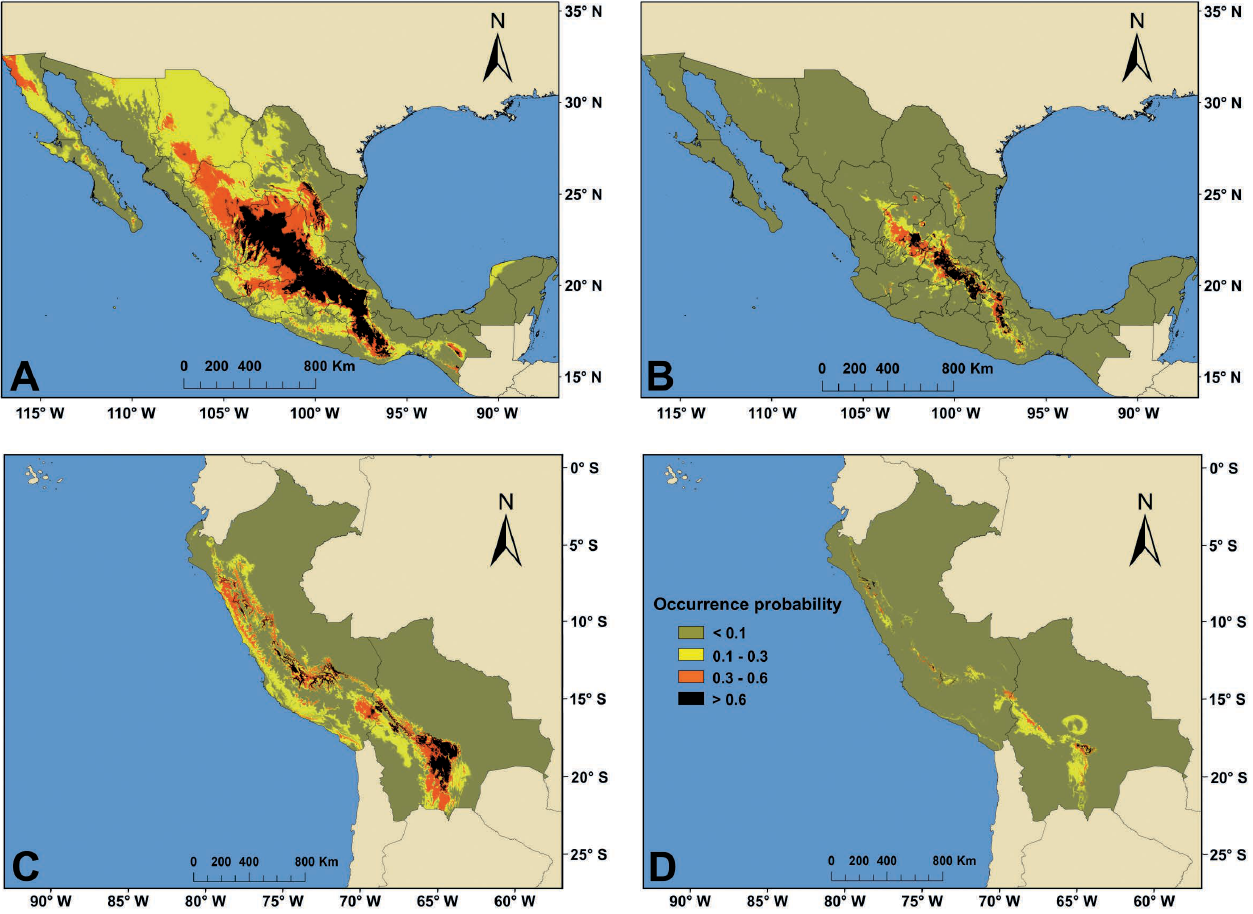
Figure 3 – Species distribution models (SDM) of the Peruvian peppertree projected to the geographic areas in which the species is invasive (Mexico) and native (Peru and Bolivia). A . SDM calibrated with data from the native region projected to the invaded area. B . SDM calibrated with data from the invaded region projected to the invaded area. C . SDM calibrated with data from the native region projected to the native area. D . SDM calibrated with data from the invaded region projected to the native